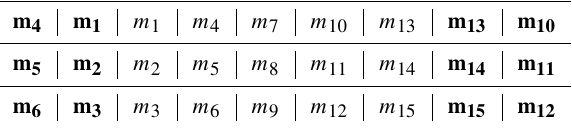
Table 1. An array of 3 × 5 with boundary points in bold.